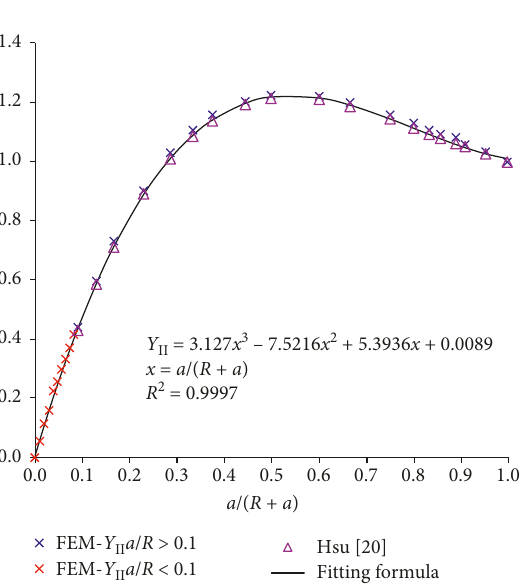
Figure 2: Normalized mode-II stress intensity factors.